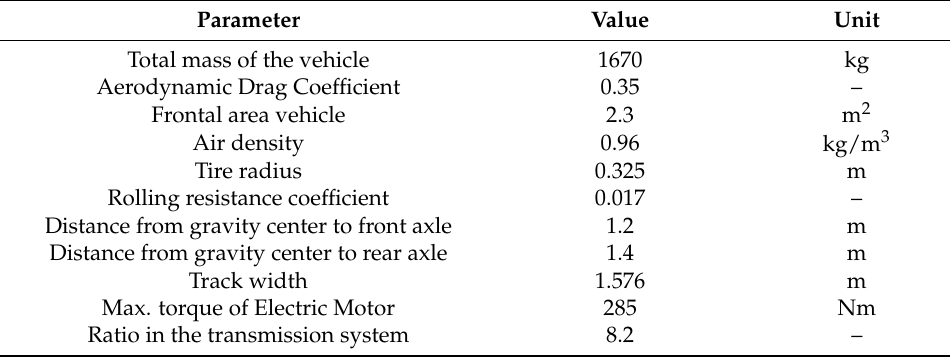
Table 2. Parameters for the dynamic model on the